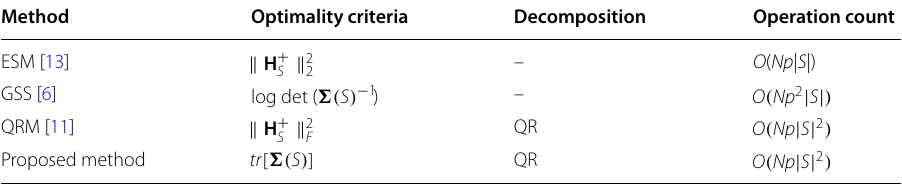
Table 1 Comparison with various greedy selection methods Method Optimality criteria